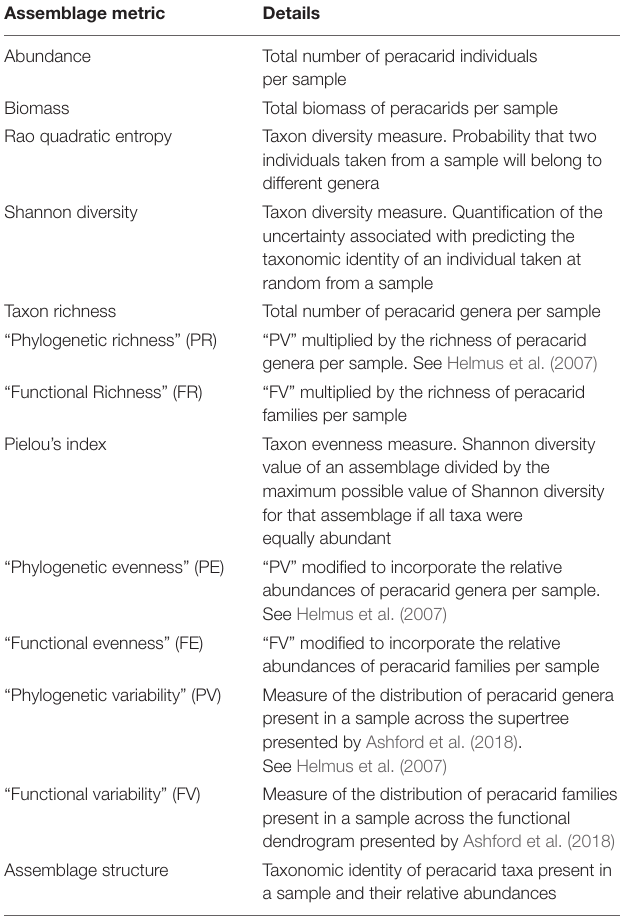
TABLE 1 | Peracarid crustacean metrics analysed in this